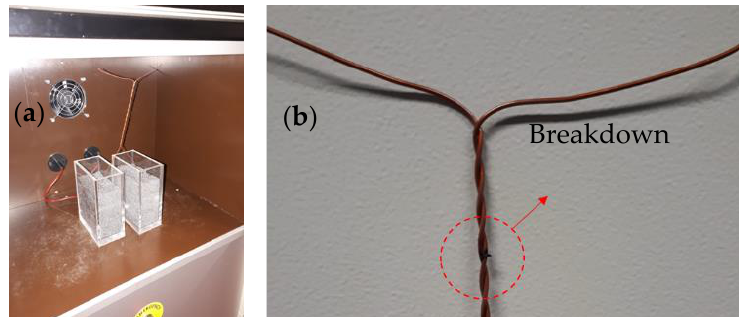
Figure 3. ( a ) Breakdown voltage device and ( b ) sample broken down.